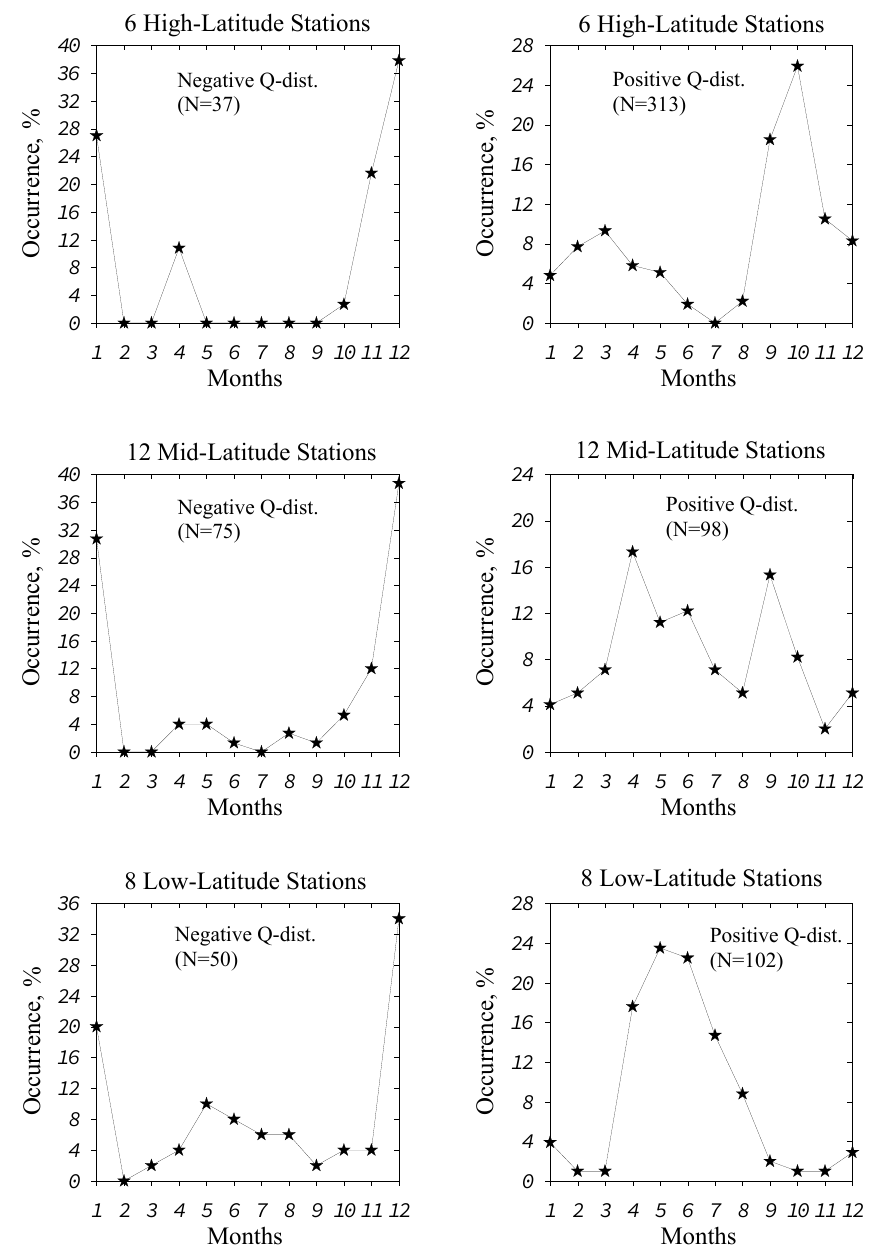
Fig. 1. Fig. 1. Seasonal variations of the occurrence for negative (left panels) and positive (right panels) Q-disturbances at high, middle, and lower latitude stations in the daytime (09:00–15:00)LT sector. All solar activity levels are put together, total number of events is given in